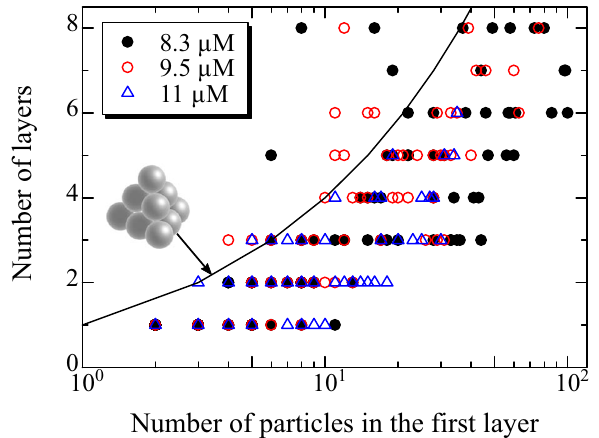
Figure 6. Relationship between the height of clusters and the number of particles in the first layer. The polymer concentration is 8.3 (filled circle), 9.5 (open circle), and 11 µ M (open triangle). The solid curve denotes the relationship when tetrahedral clusters are